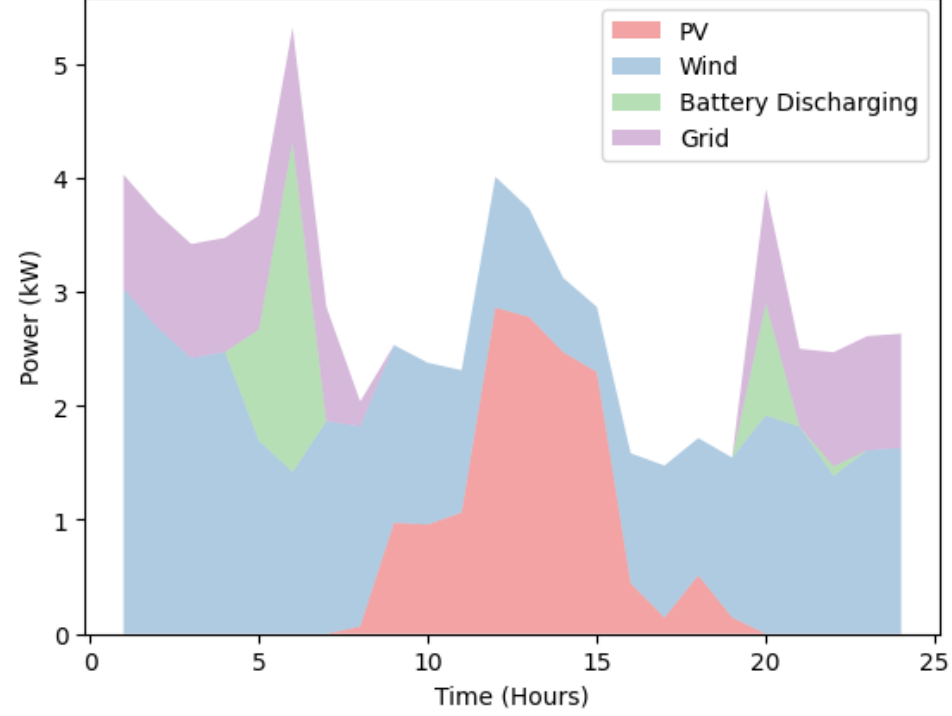
Figure 9. Total production of the community on the first day after applying the